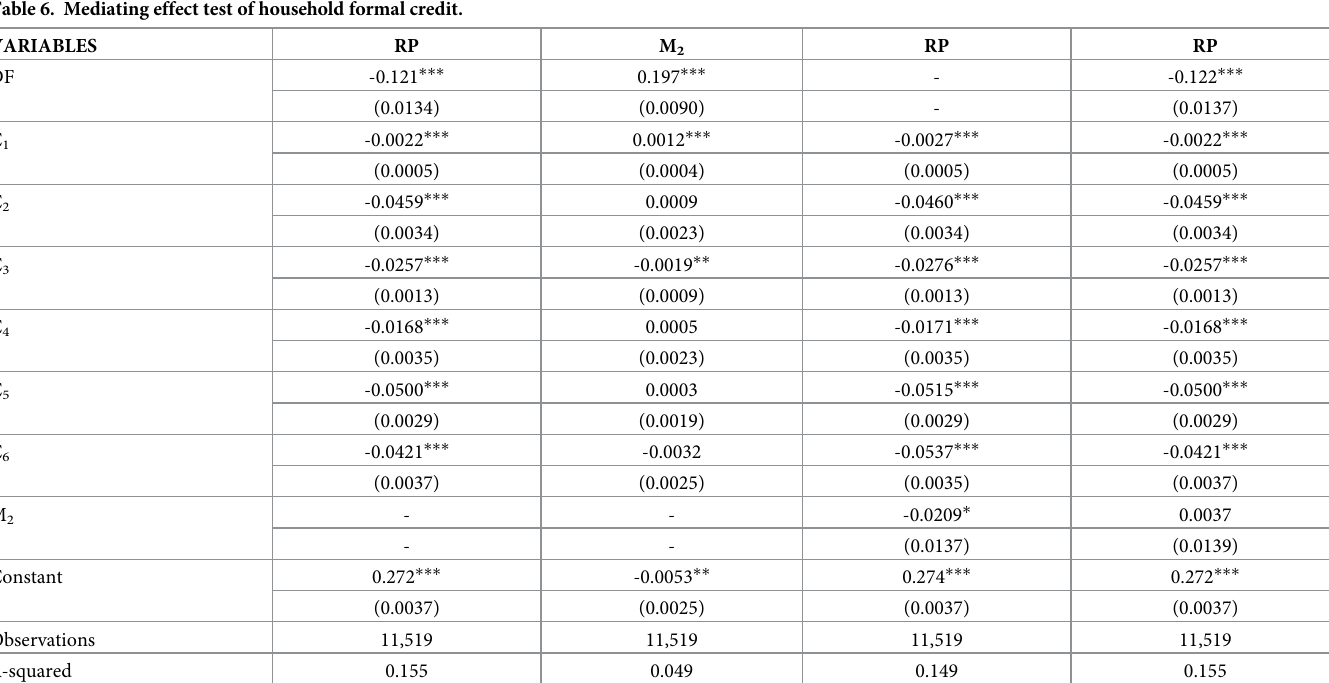
Table 6. Mediating effect test of household formal